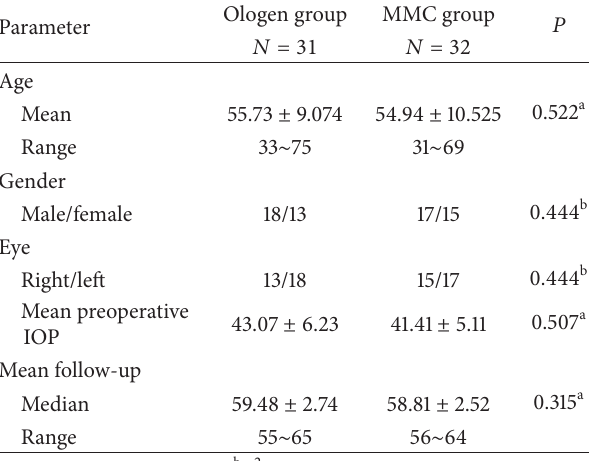
Table 1: Preoperative characteristics of patients in both groups.